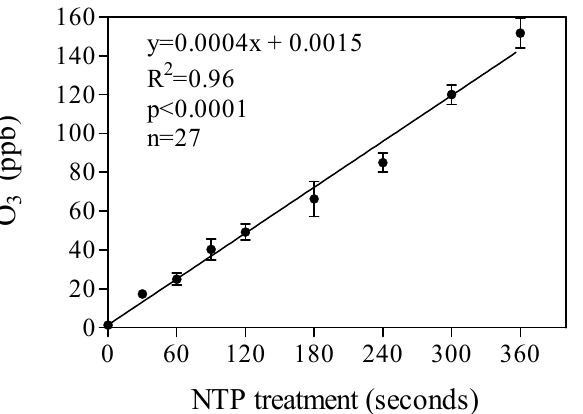
Figure 2. Linear regression between peak ozone (O 3 ) concentration in air inside hydroponic growing system and operating time of NTP generator used to treat nutrient solution in hydroponic tank. Each value is mean ( ± SE of three measurements taken in three different occasions over 24 h of system operation (experiment 1). Regression equation and determination coefficient (R 2 ) shown inside graph.